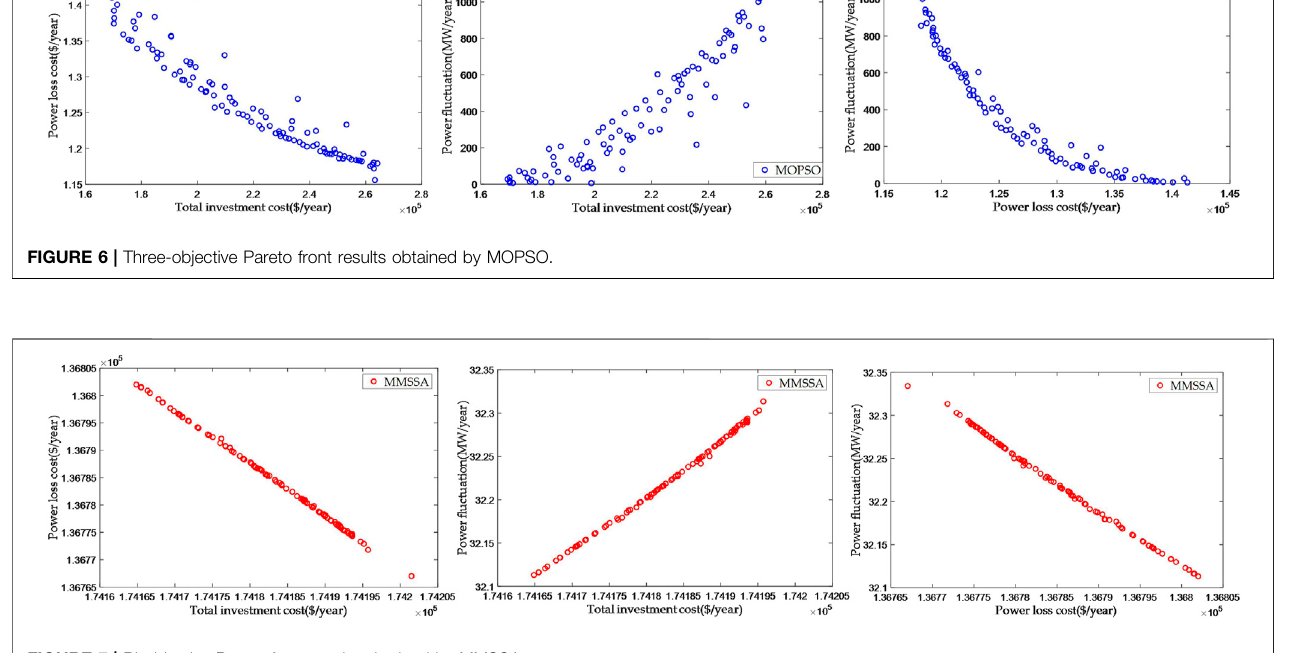
FIGURE 7 | Bi-objective Pareto front results obtained by